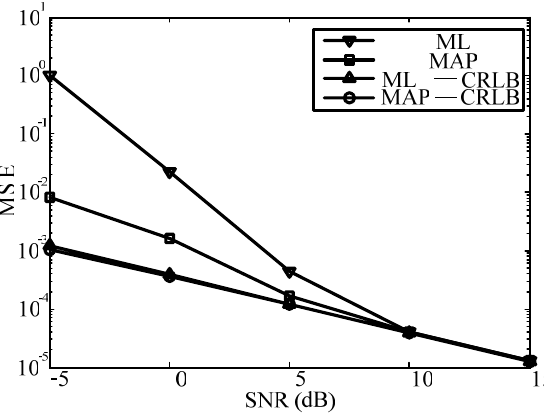
Table 2. Simulation condition of MAP estimation algorithm Parameters Length of orthogonal training sequence Range of normalized frequency offset （ 1 ）